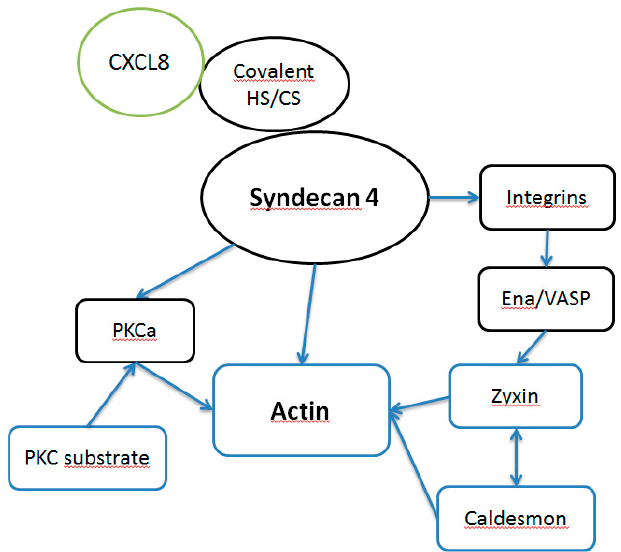
Figure 4. Scheme of potential GAG mediated CXCL-8 downstream signaling. Proteins in blue boxes were found to be differentially regulated upon CXCL-8 treatment.